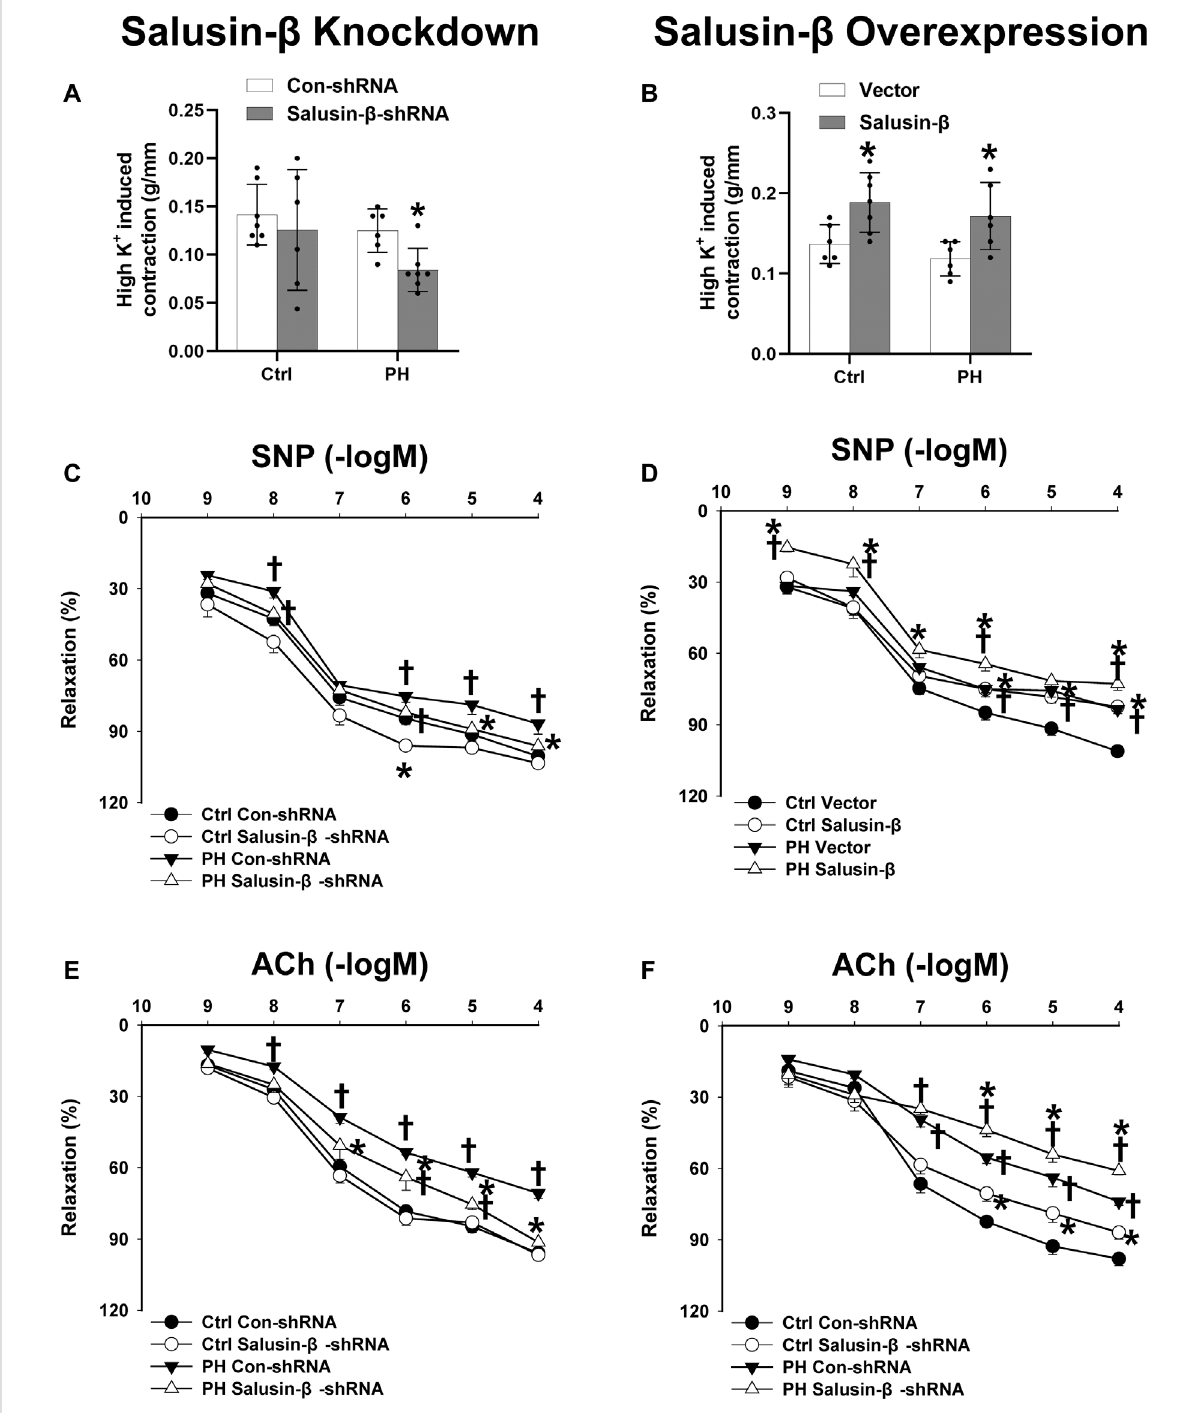
FIGURE 2 Effects of salusin- β knockdown on high K + solution-induced contraction (A) , sodium nitroprusside (SNP)-induced relaxation (C) , and acetylcholine (ACh)-induced relaxation of PAs (E) ; as well as the effects of overexpression of salusin- β on high K+ solution-induced contraction (B) , SNP-induced relaxation (D) , and ACh-induced relaxation of PAs (F) in control and MCT-induced PH rats. Values are mean ± SE. * p < 0.05 compared with Con-shRNA or vector. † p < 0.05 compared with control (Ctrl) rats. n = 6 – 9 for each